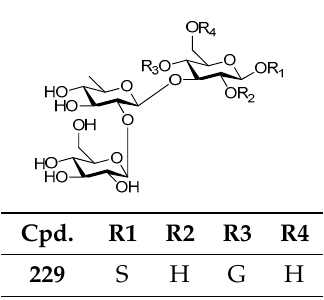
Figure 41. Structure of compound 228 .